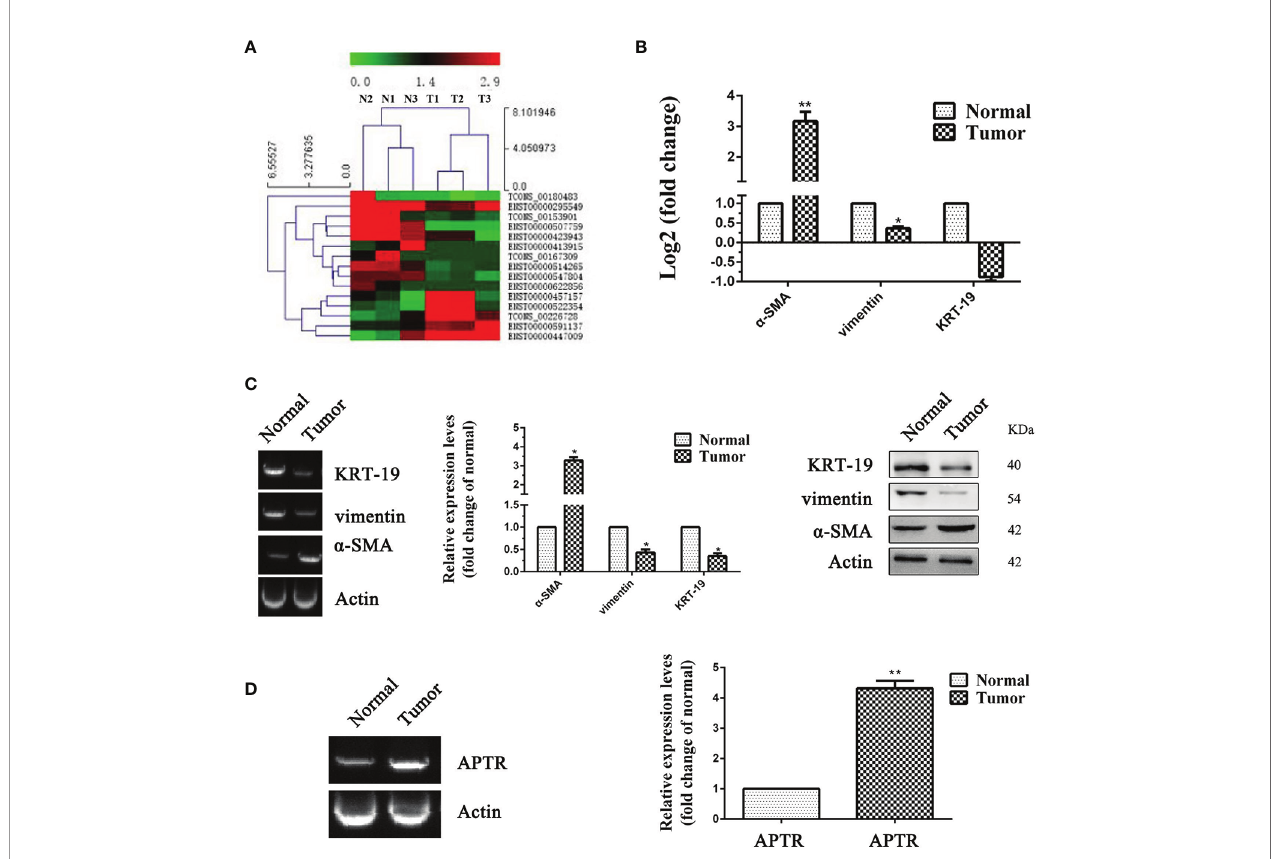
FIGURE 1 | LncRNA expression was high in leiomyoma tumors. (A, B) Differences in RNA transcription were detected between normal uterine tissues and leiomyoma tumors. High-level pathway sequencing showed that a -SMA expression was higher in leiomyoma tumors. (C) Gel electrophoresis, real-time PCR, and Western blot analyses con fi rmed higher a -SMA expression and lower vimentin and KRT-19 expression in leiomyoma tumors. (D) Gel electrophoresis and real-time PCR analyses con fi rmed higher APTR expression in leiomyoma tumors. (* P < 0.05, ** P <